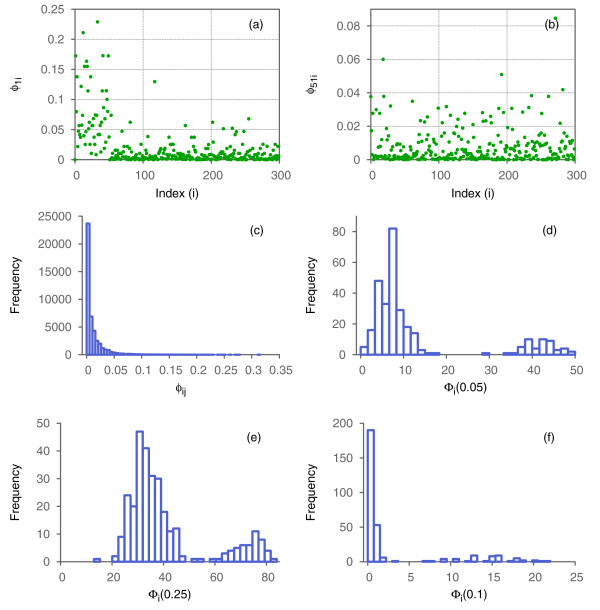
Complexity analysis of the artificially generated graph. Plots of (a)ϕ1jand (b)ϕ51j. (c) Histogram of ϕijfor all pairs of nodes in the graph. Histograms of Φi(T)for (d)T=0.05, (e)T=0.025, and (f)T=0.1.